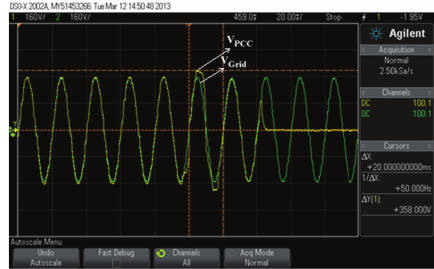
+ 𝑃 Deriving 𝑃 and from DG Grid